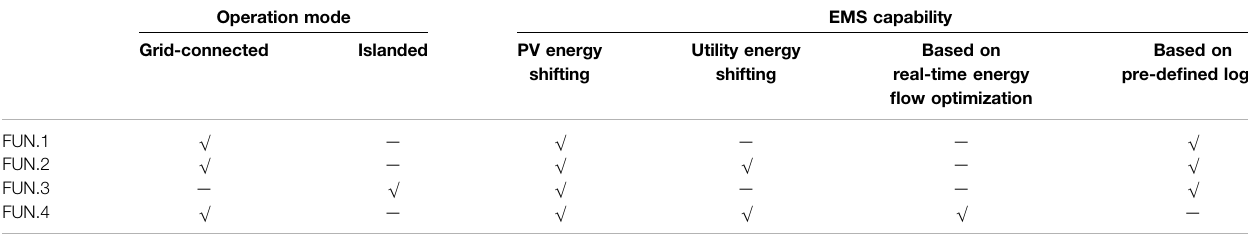
TABLE 1 | Overview on the functionalities in tertiary control